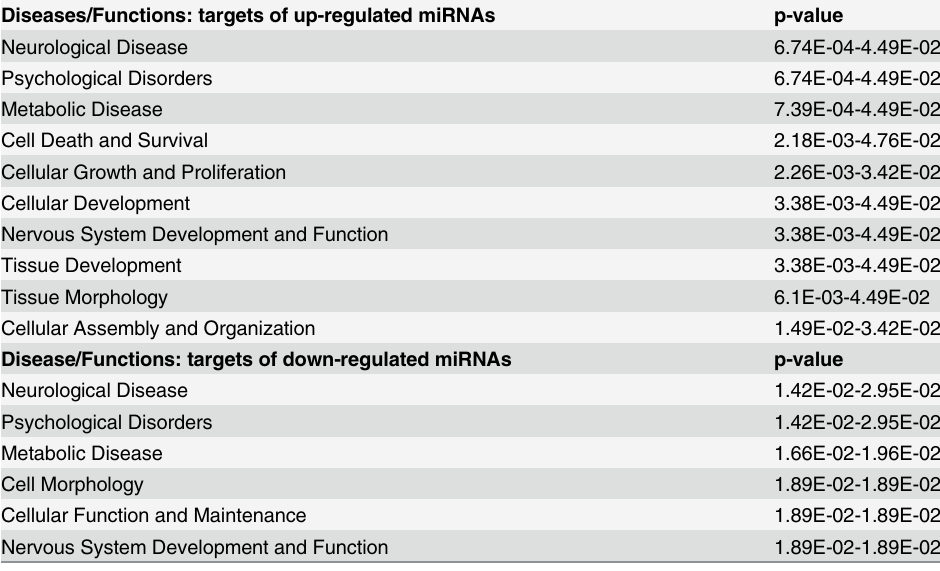
Ingenuity Pathway Analysis (IPA), Diseases/Functions category of mRNA targets of differentially expressed miRNAs. Table shows top IPA diseases and functions for predicted gene